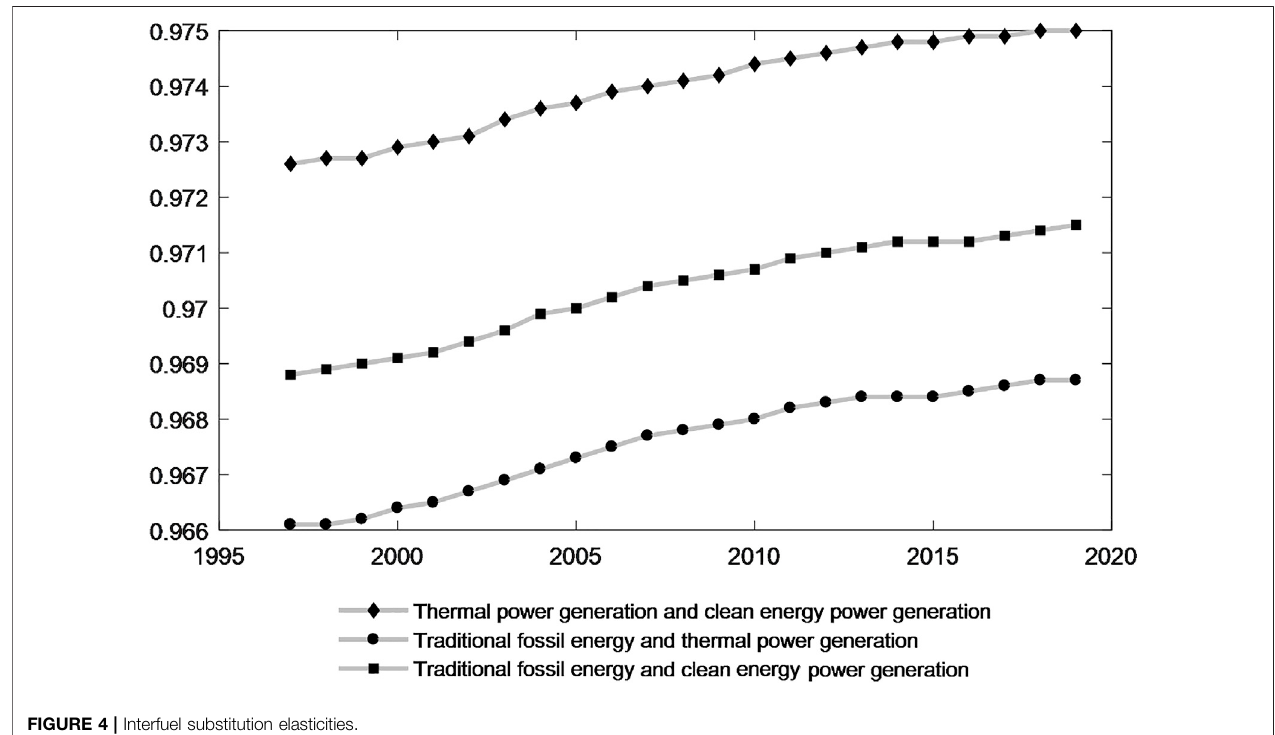
FIGURE 4 | Interfuel substitution elasticities.